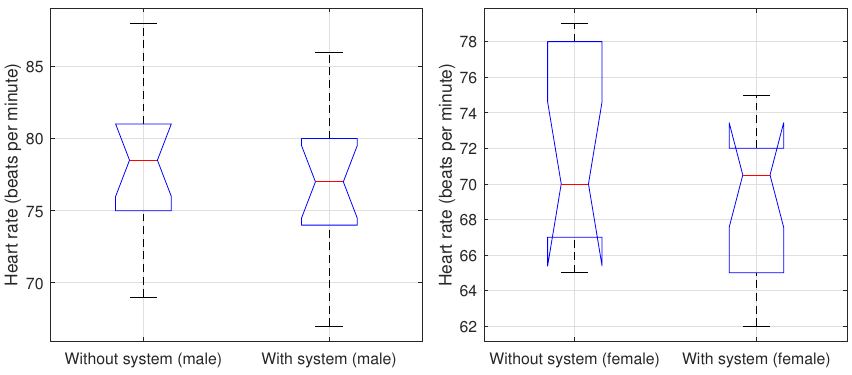
Figure 4. Heart rate with and without the monitoring system for men and